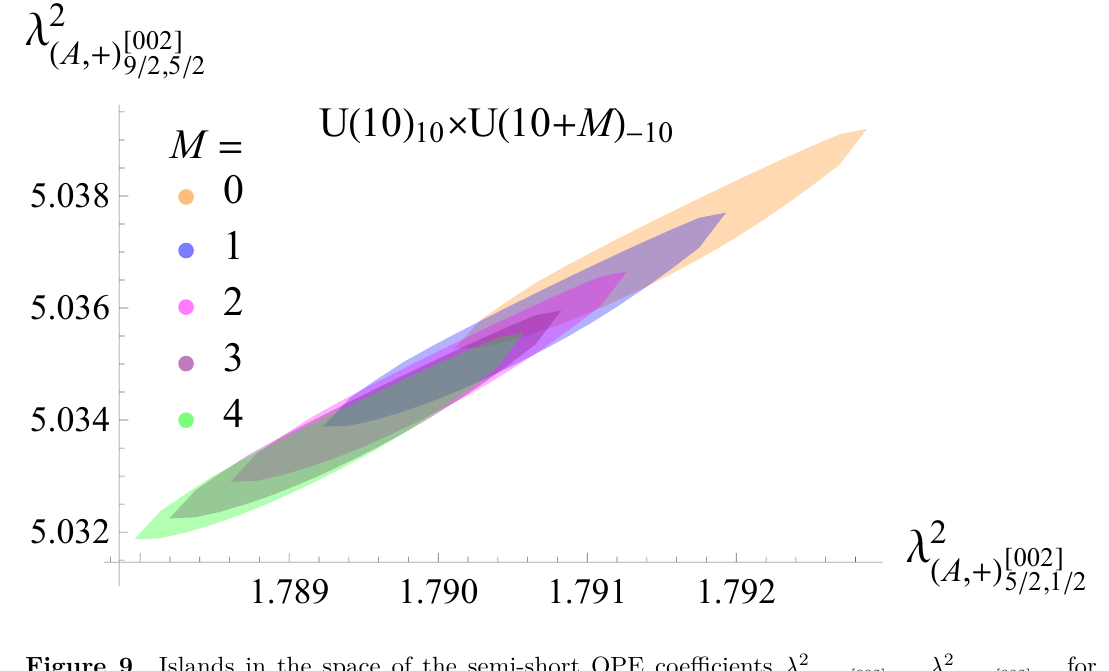
Figure 9 . Islands in the space of the semi-short OPE coefficients λ 2 U(10) 10 × U(10 + M ) − 10 ABJM theory for M < k/ 2 = 5 . These bounds are derived from the N = 6 bootstrap with Λ = 39 derivatives, and with c T and λ 2 theory using the all orders in 1 /N localization formulae in [10] for N = 10 . Note that the axes describe a very narrow range in parameter